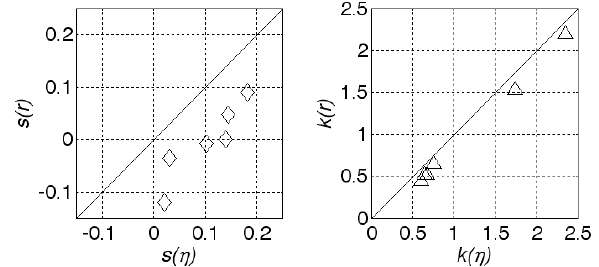
Fig. 10. Skewness and kurtosis of wave runup distribution with respect to those for the incident wave field.